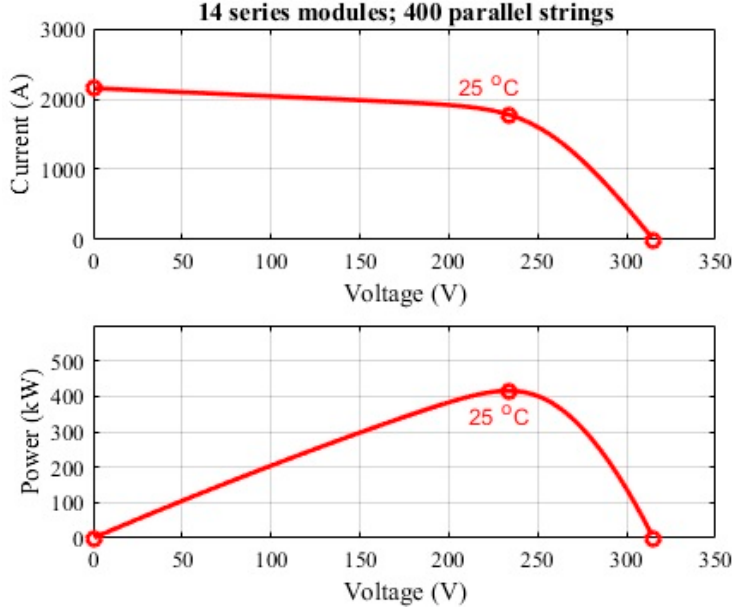
Figure 8. Current-voltage and power-voltage characteristics of the solar power plant model .